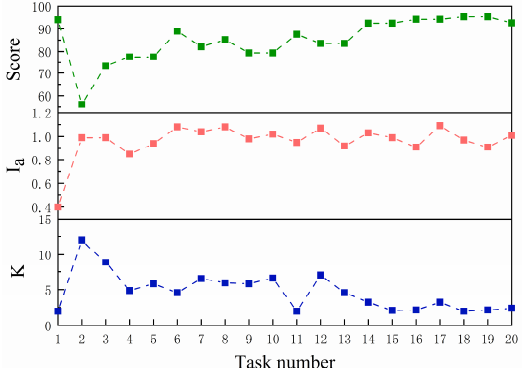
Figure 13. S1’s task trajectory diagram in FAP mode: ( a ) task1, ( b ) task7, and ( c ) task19.